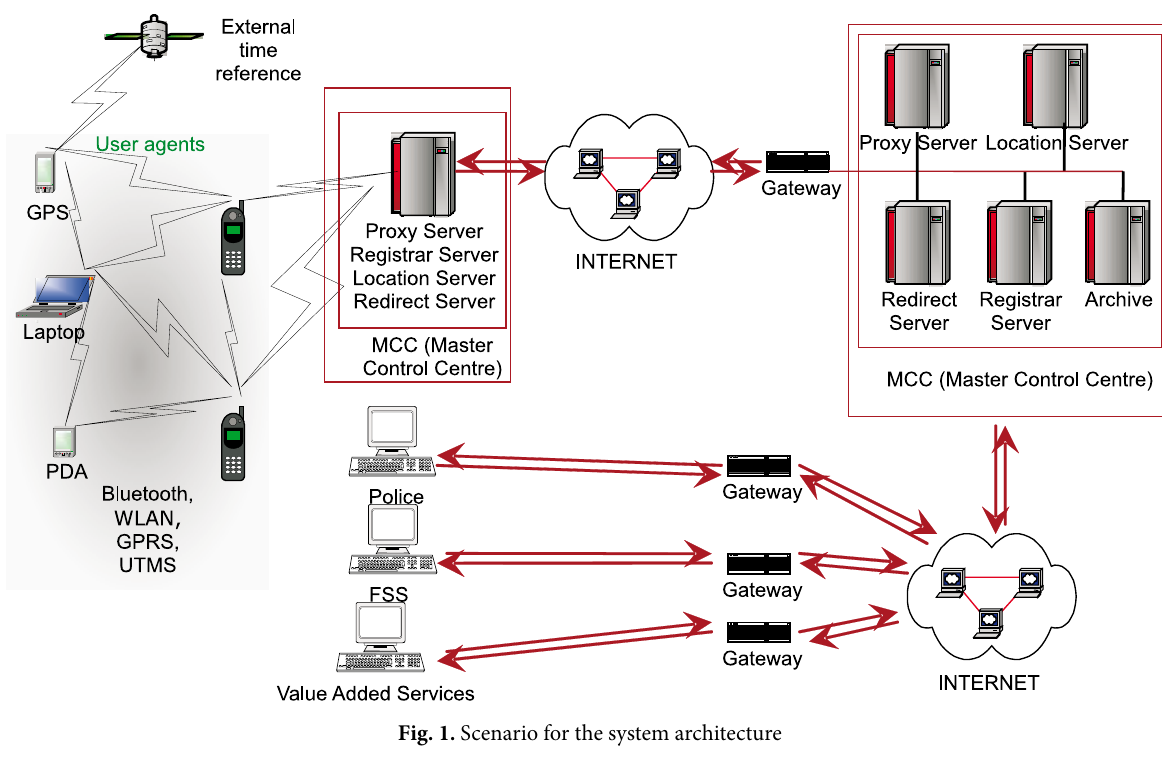
Fig. 1. Scenario for the system architecture